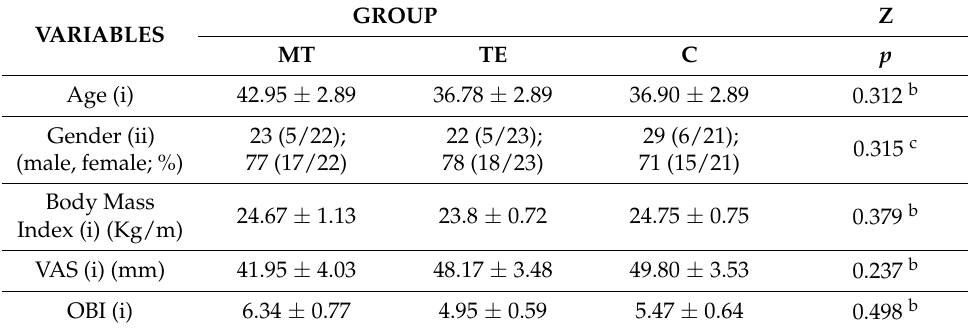
Table 1. Participants’ baseline characteristics according to the study group.